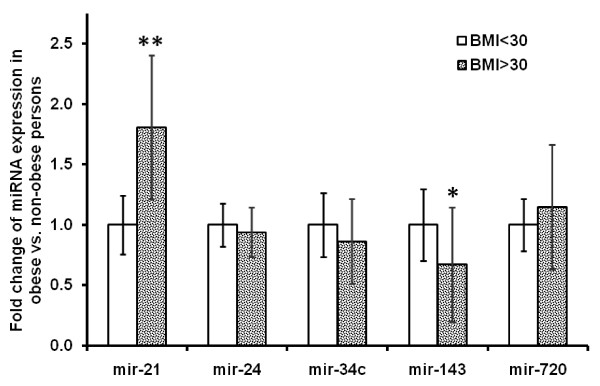
Expression levels of mir-21, mir-24, mir-34c, mir-143 and mir-720 were measured in subcutaneous adipose tissue of obese (BMI >30, n = 10) and non-obese (BMI <30, n = 10) healthy persons. miRNA expression levels are normalised to RNU48 and shown as fold change from the expression level of the non-obese persons. * depicts p < 0.05, ** depicts p < 0.001.